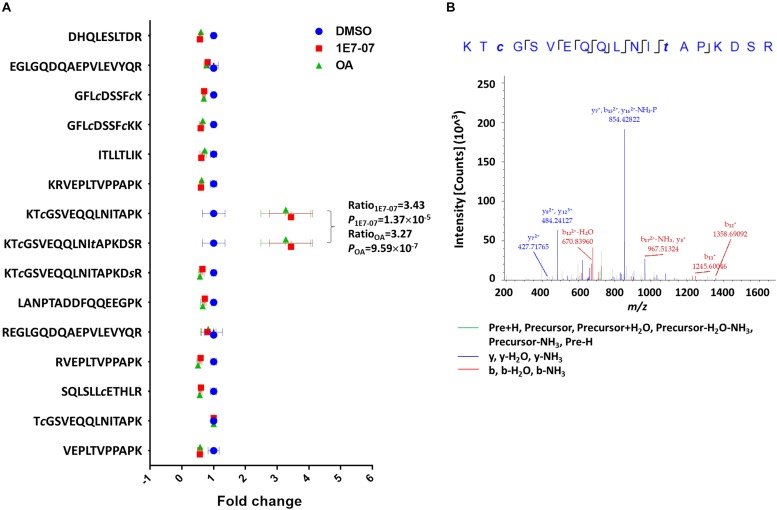
Effect of 1E7-07 on VP30 phosphorylation. (A) Label-free quantitative analysis of VP30. HEK293T cells were transfected with Flag-VP30 and treated with 1E7-07 and OA. VP30 was immunoprecipitated from cellular lysates with anti-Flag antibody, resolved by SDS-PAGE, and analyzed by LC-MS/MS. VP30-derived peptides were identified by Proteome Discoverer 1.4. Quantification was performed on SIEVE 2.1 software. Mean intensities (± SD) of the indicated VP30 peptides are shown. Ratio and P-value of phosphopeptides KTcGSVEQQLNItAPKDSR and KTcGSVEQQLNITAPKDsR were labeled. (B) Representative MS/MS spectrum of the phosphopeptide 107KTcGSVEQQLNItAPKDSR125. The colored peaks indicate matched MS/MS fragments. Green color indicates precursors, as outlined in the figure; blue and red colors indicate y and b ions, respectively.